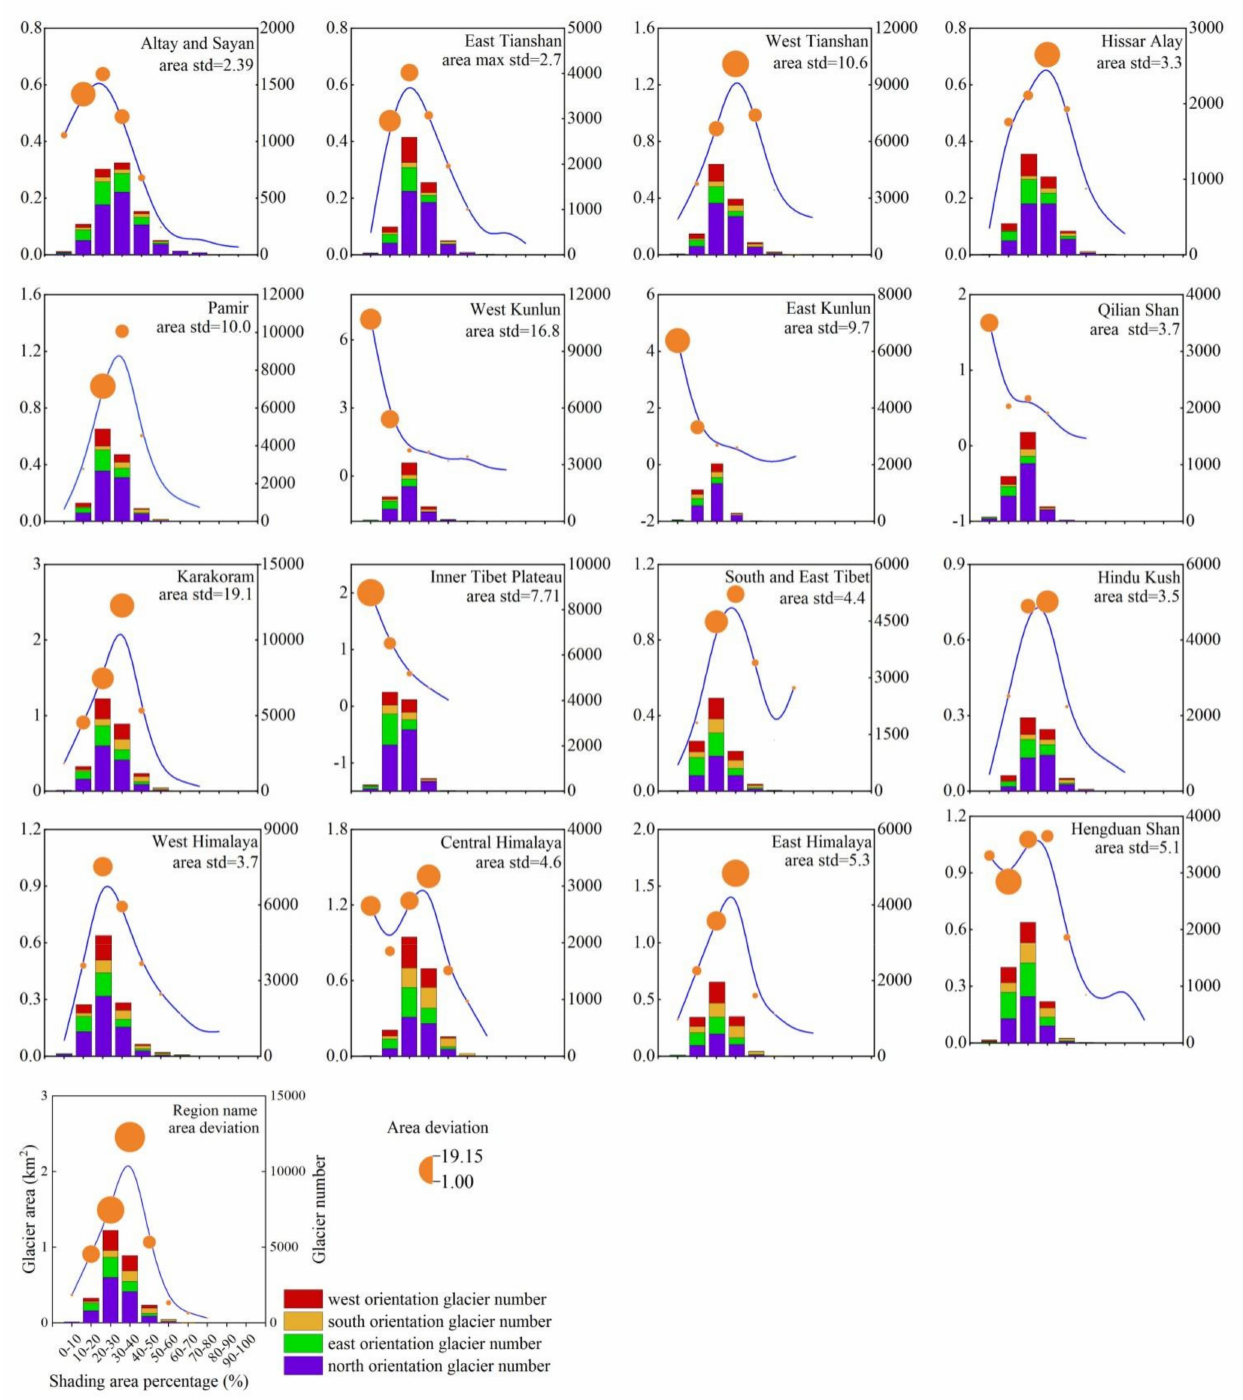
Figure 6. Changes in the shading area percentage with the glacier area for each region within HMA. The glacier area refers to the average area of the regional glaciers. The area std is the standard deviation of the regional glacier